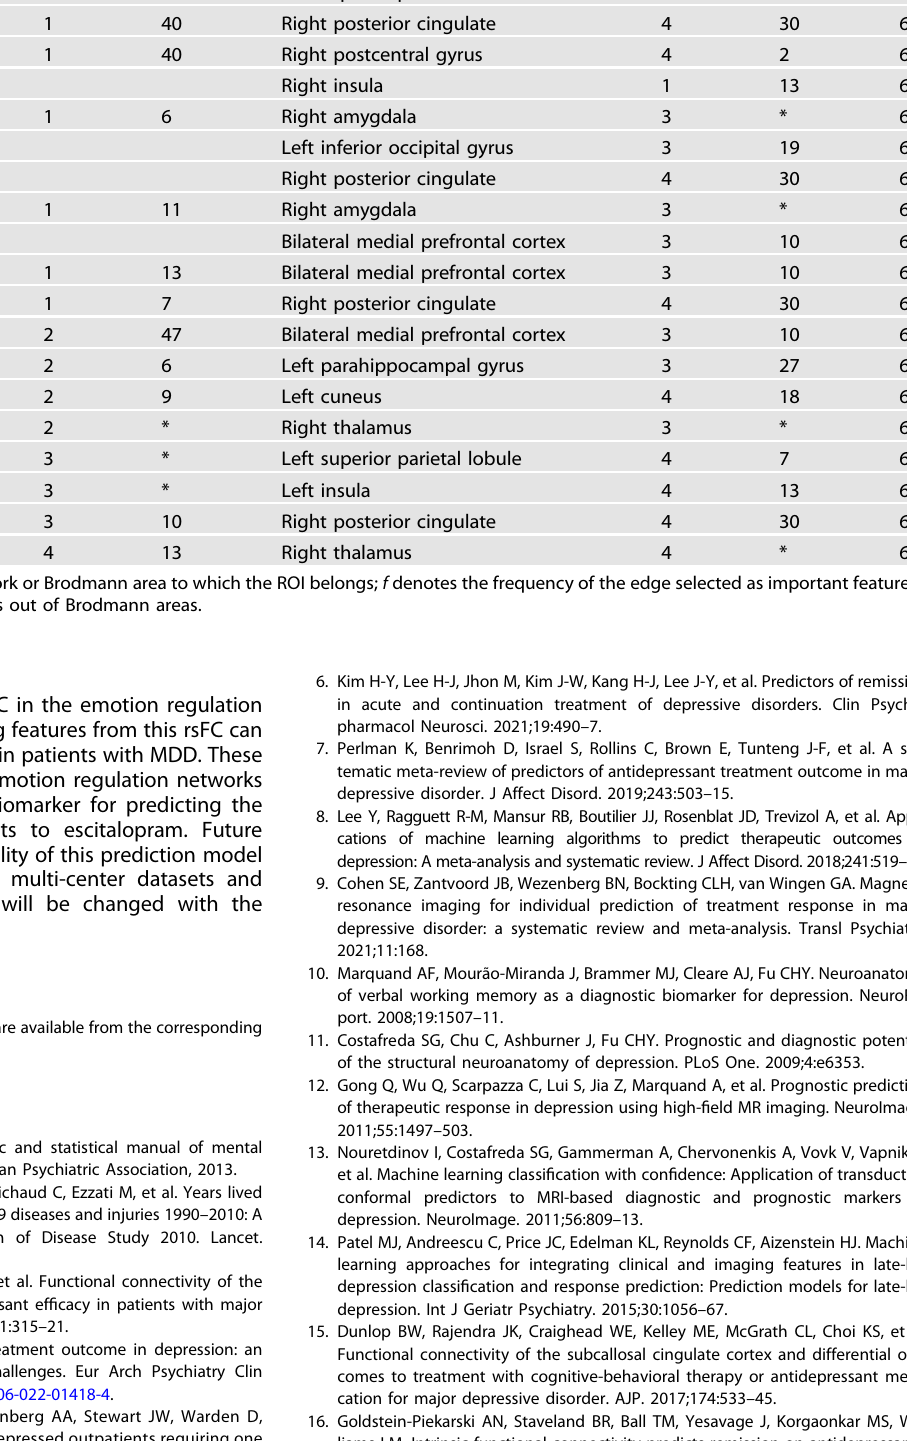
Right middle frontal